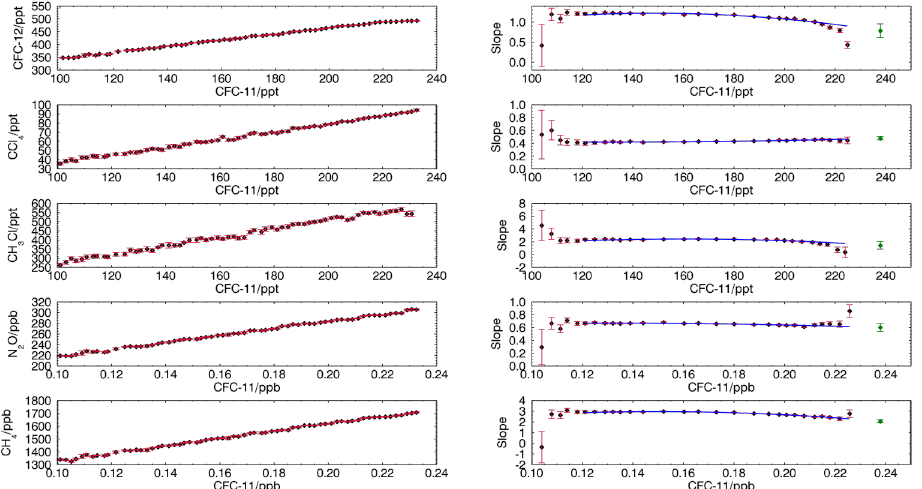
Figure B19 Correlations between the volume mixing ratios of CFC-12, CCl 4 , CH 4 , CH 3 Cl and N 2 O and CFC-11 for the data from the southern hemisphere during the stratospheric winter of 2008. Left panels: The mean correlation profile. Each point represents the mean of the VMR in a window of 2 ppt of CFC- 11. The error on these points is the standard deviation of the data within each 2 ppt window. Right panels: The local slope of data in an 80 ppt of CFC-11 window. The error on the points is the fitting error of this fit. The blue line is a second degree polynomial fit to the local slopes. The green point is the extrapolated slope at the tropopause.